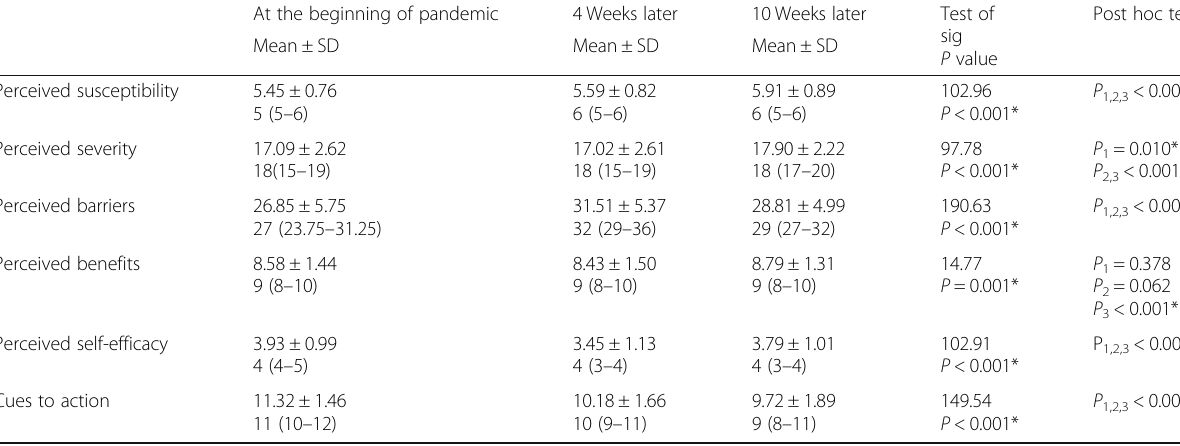
Table 2 Distribution of health belief model constructs for COVID-19 preventive behaviours over three periods of time At the beginning of